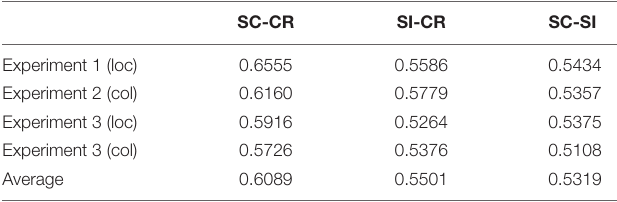
TABLE 2 | The average AUCs of the ROC curves for the three different classification problems on four experiments. SC-CR SI-CR SC-SI